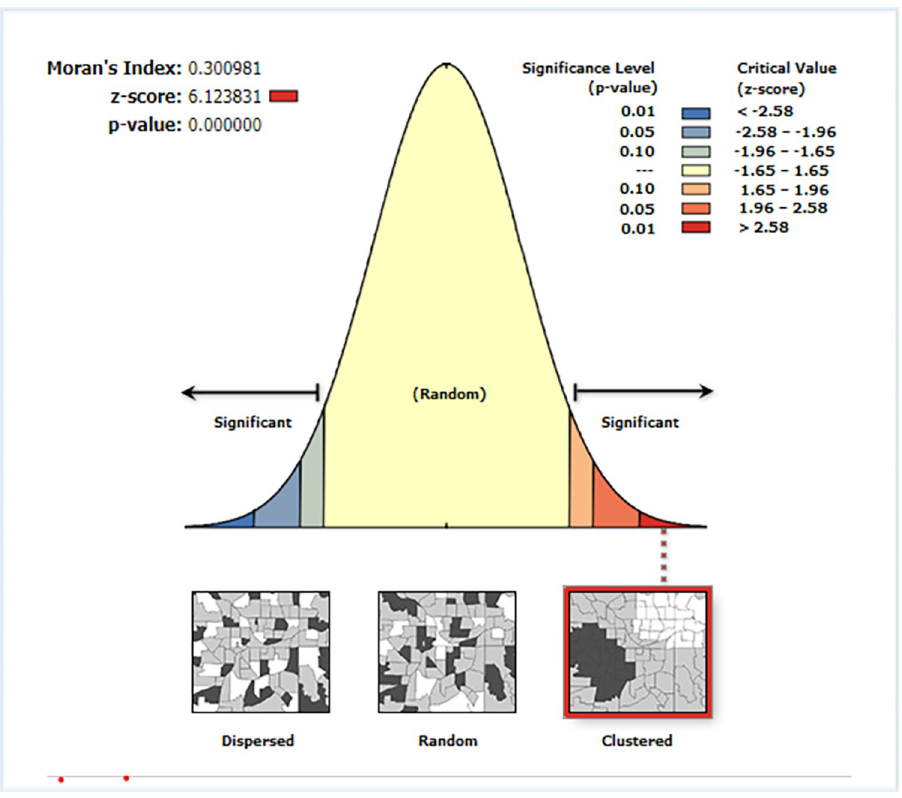
Fig 3. Spatial autocorrelation of alcohol consumption among pregnant women in Ethiopia, 2016 EDHS